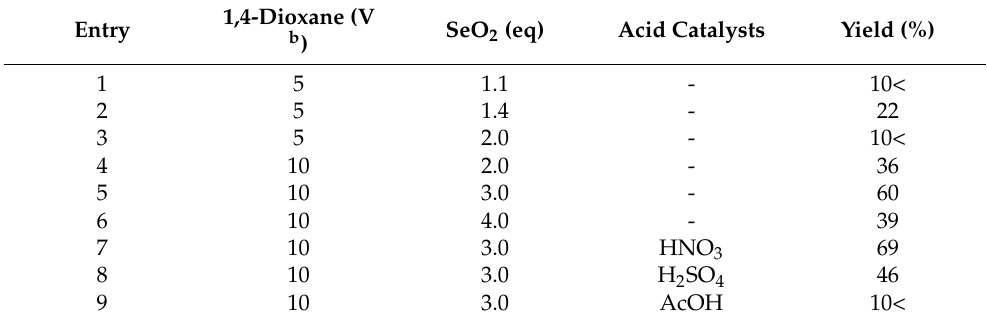
Table 4. Optimization of the reaction conditions for the oxidation of compound 4 a to aldehyde 6.